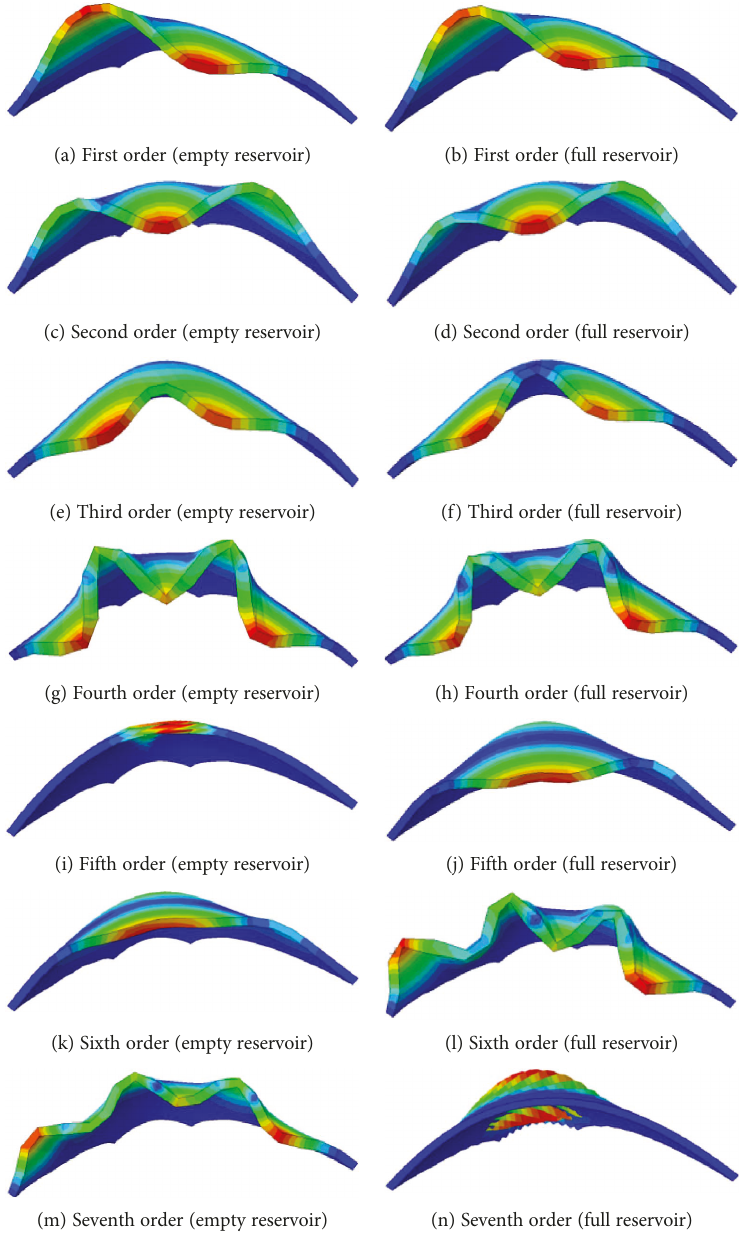
Figure 2: Vibration modes of arch dam under empty-reservoir and full-reservoir working conditions.